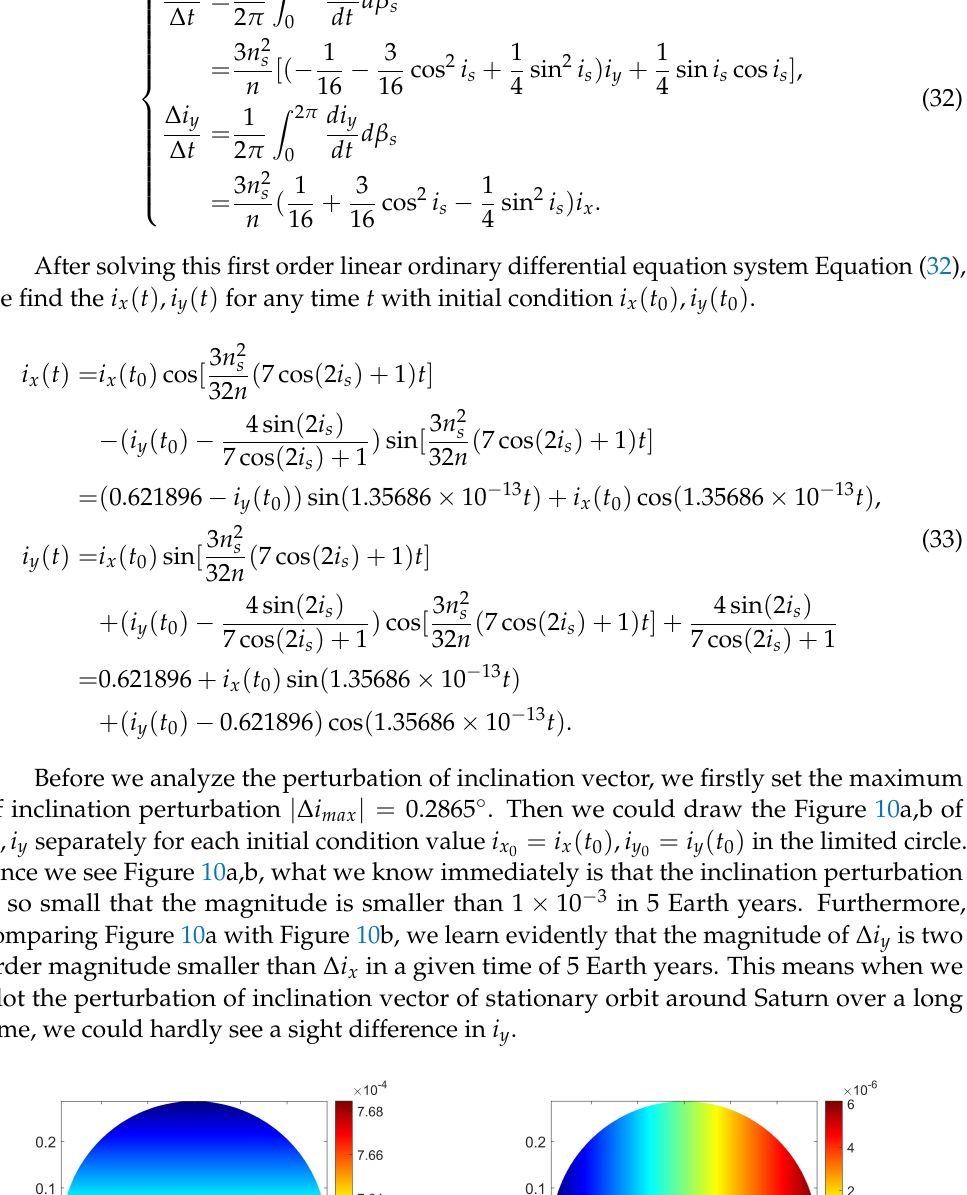
Figure 10. ( a ) ∆ i x ( b ) ∆ i y after 5 Earth years with initial inclination vector point ( i x inclination limited circle whose radius r = 0.2865 deg perturbed by solar